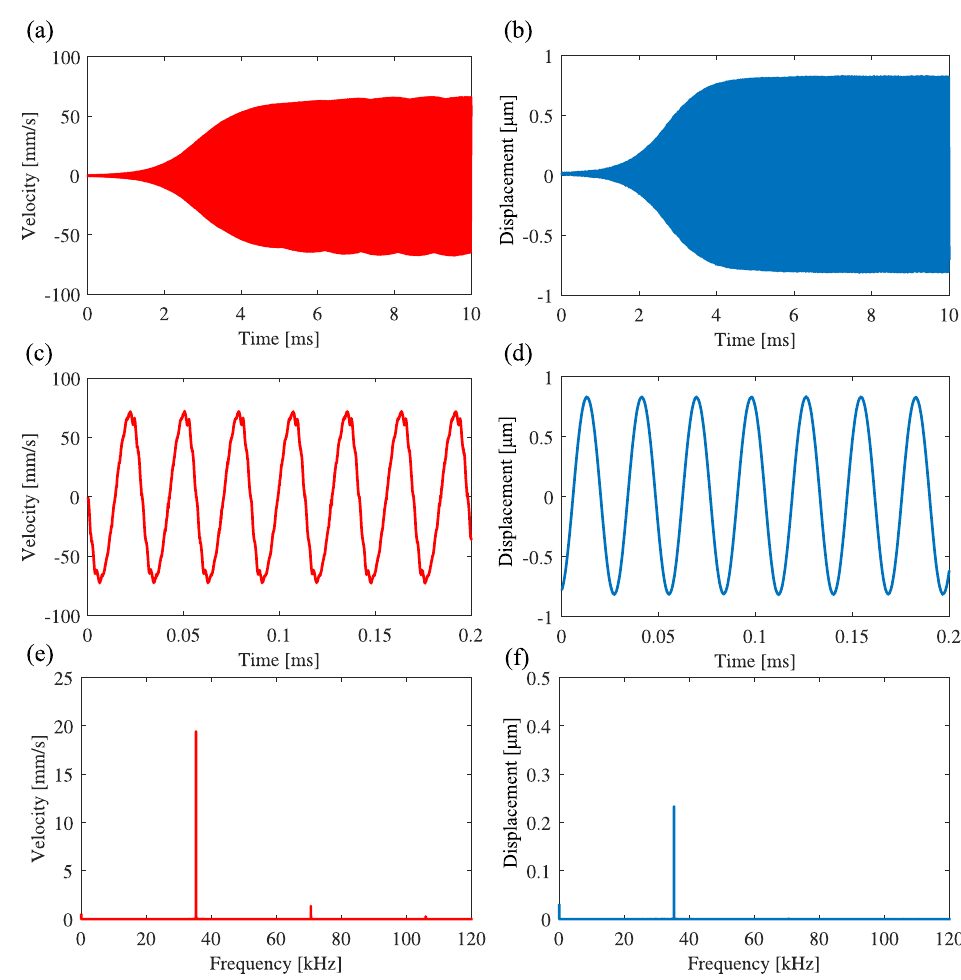
Figure 8. Self-excited oscillation with first mode under feedback control in the case without band-pass filtering: g 1 = − 2, g 3 = 250. ( a , b ) are the time histories of the cantilever and the control signal to the piezoelectric actuator. ( c , d ) are the expansions of ( a , b ) in the steady state, respectively. ( e , f ) are the FFT analysis for the oscillation of the beam and the excitation displacement,